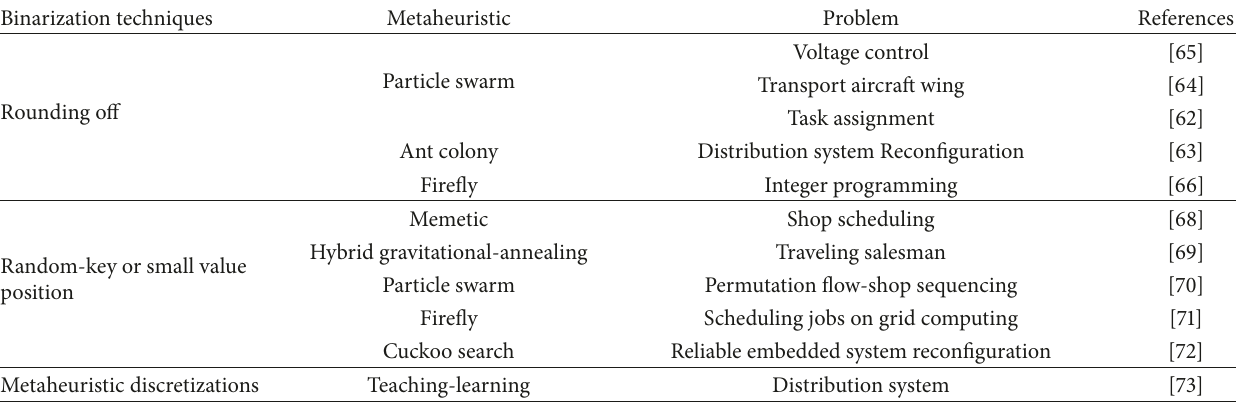
Table 4: Summary of discretization